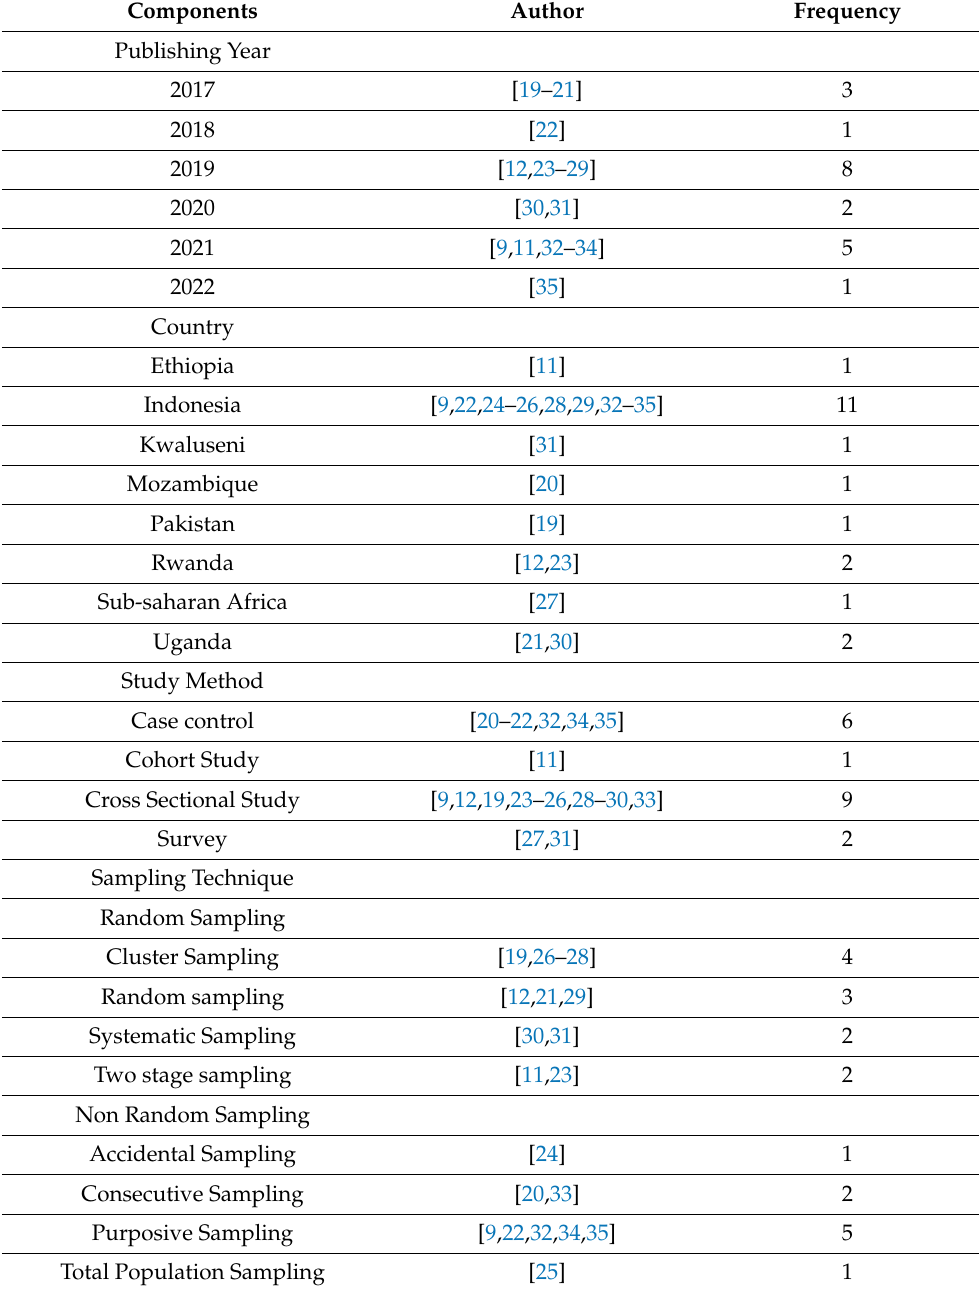
Table 1. Study Characteristics ( n =